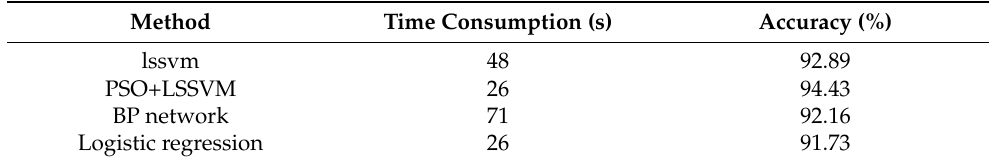
Table 5. There are three types of experimental results for the evaluation criteria of operational efficiency.